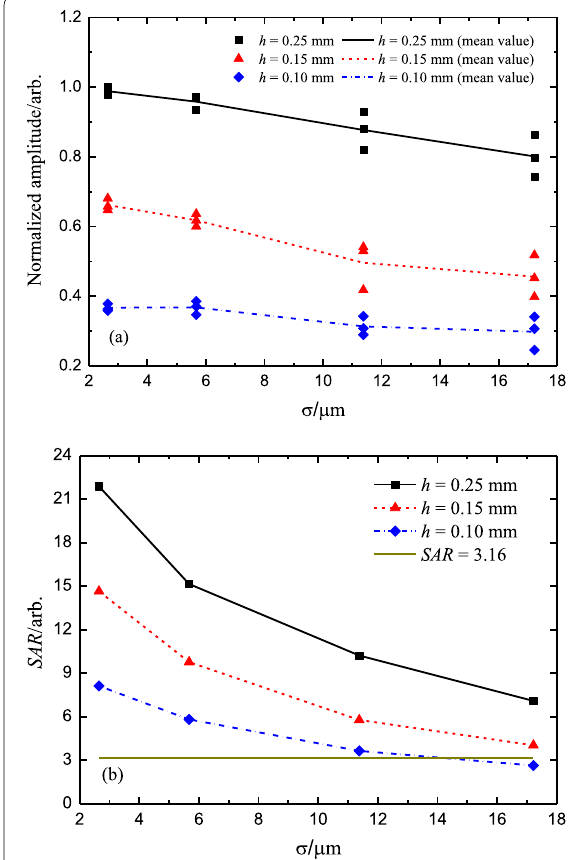
Figure 13 a Normalized amplitudes and mean values and b SAR values of micro-cracks under rough back